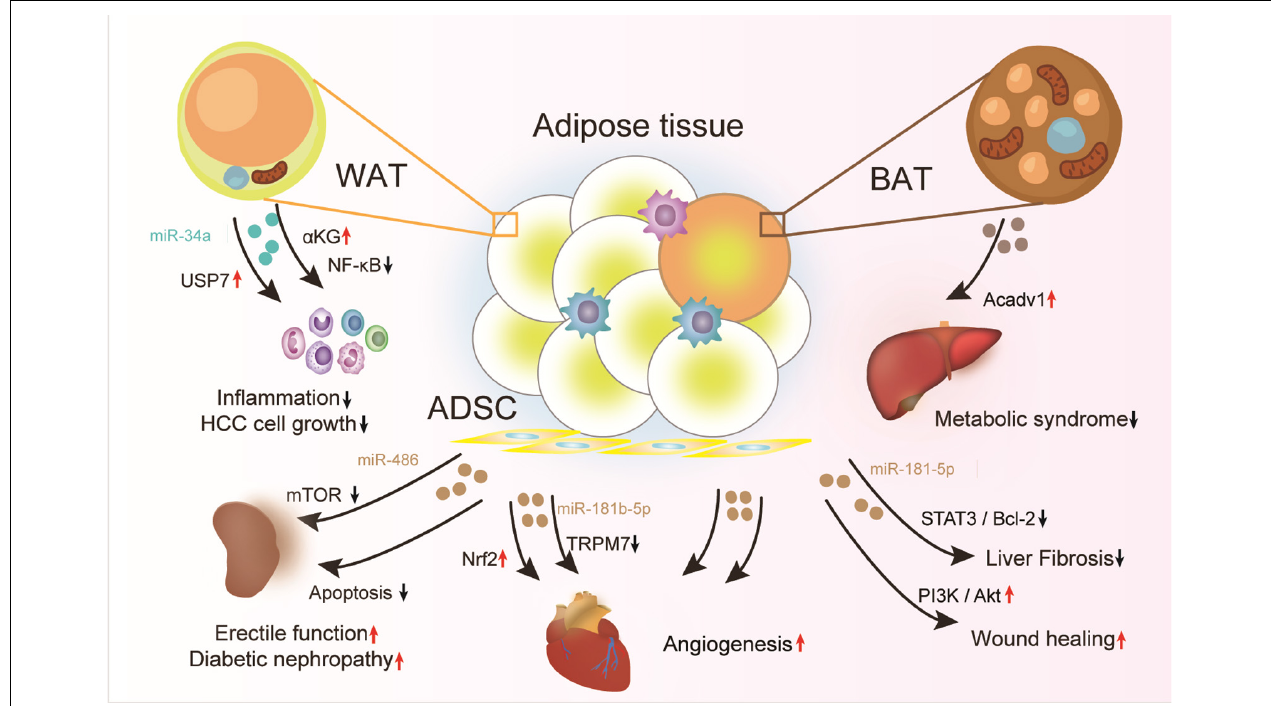
FIGURE 3 | Therapeutic effects of adipose tissue-derived exosomes. Exosomes from healthy adipose tissue, specifically the adipose in lean, the brown adipocytes, and the ADSCs have great therapeutic potential for types of diseases, such as inflammation, metabolic syndrome, and endothelial dysfunction. Moreover, the adipose tissue should be engineered with chemical drugs or gene modification for production of exosomes with improved therapeutic effects.